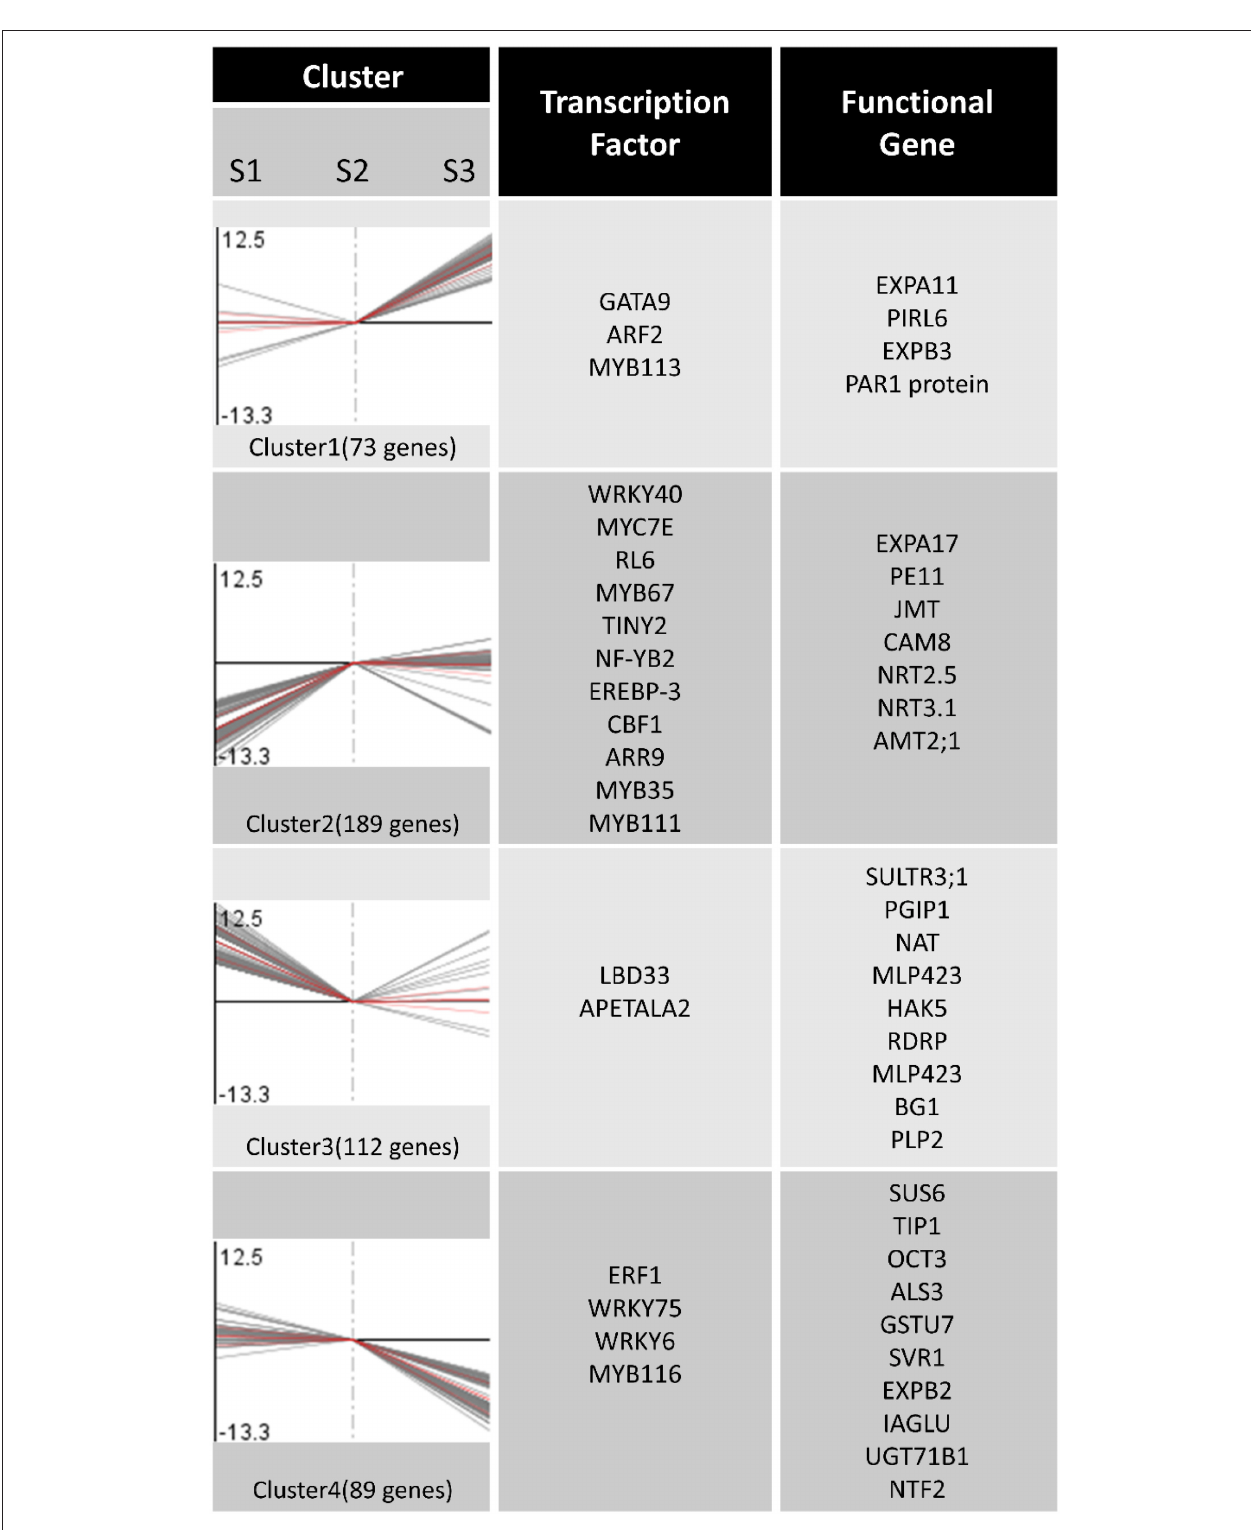
Frontiers in Plant Science | www.frontiersin.org